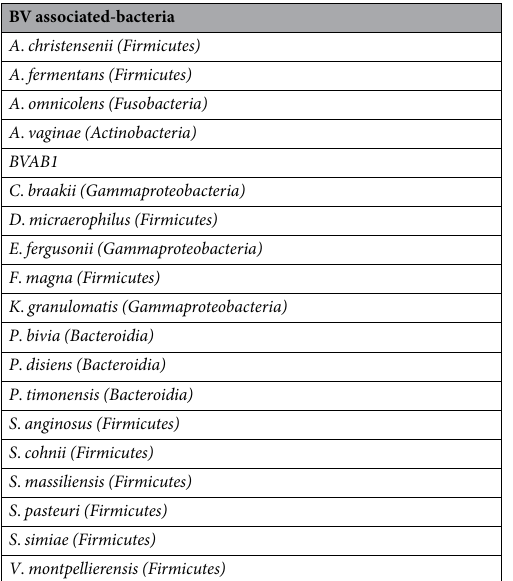
Table 2. BV associated-bacteria. Bacterial identities that were uniquely identified in the Vaginosis